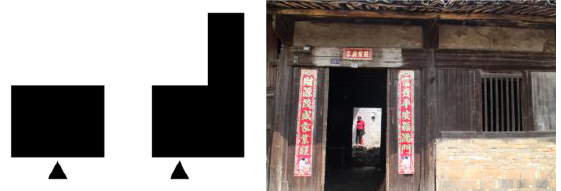
Figure 4. The mode chart of "line-styled" and the "L-styled"